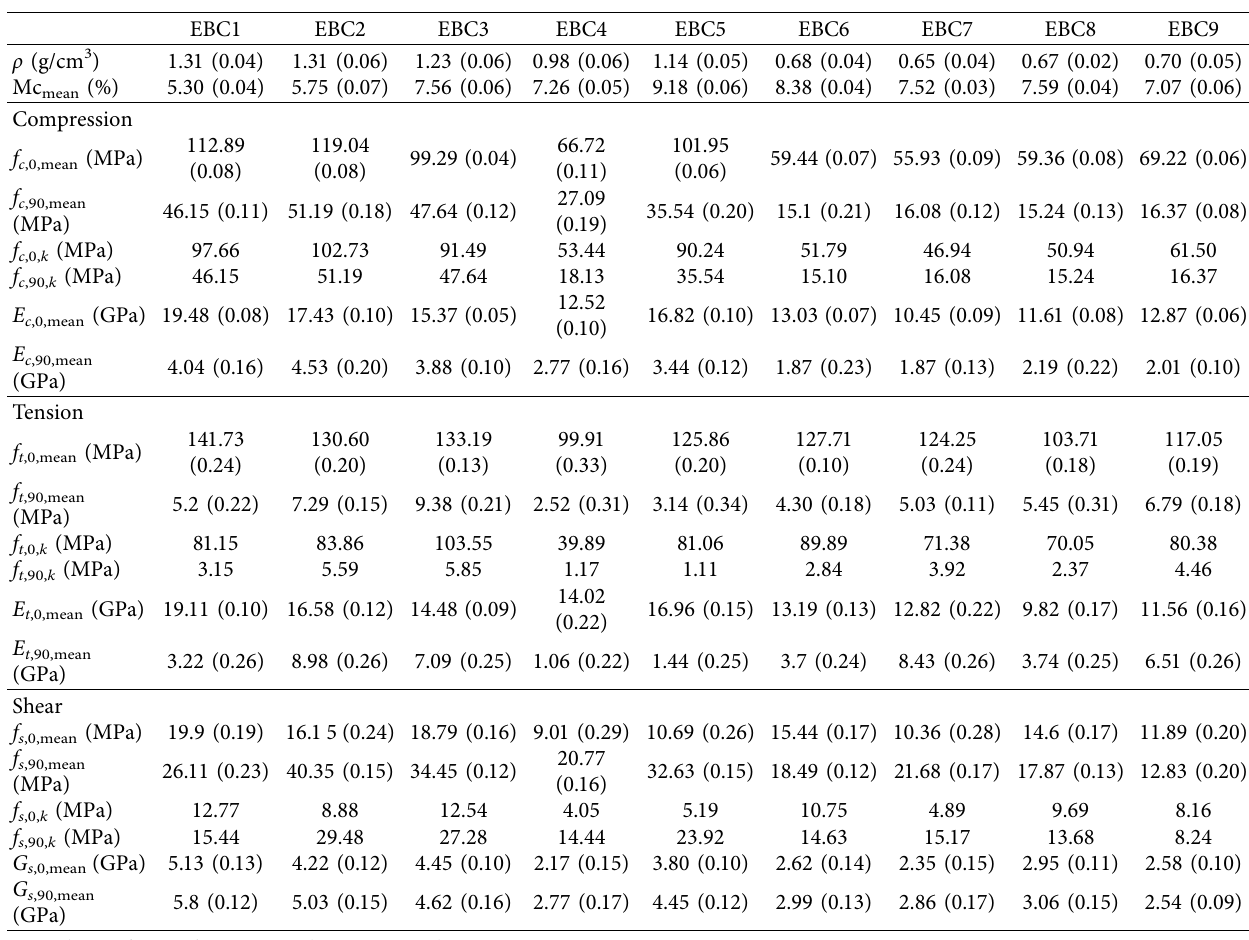
Table 3: Summary of experimental results and characteristic values for EBC.